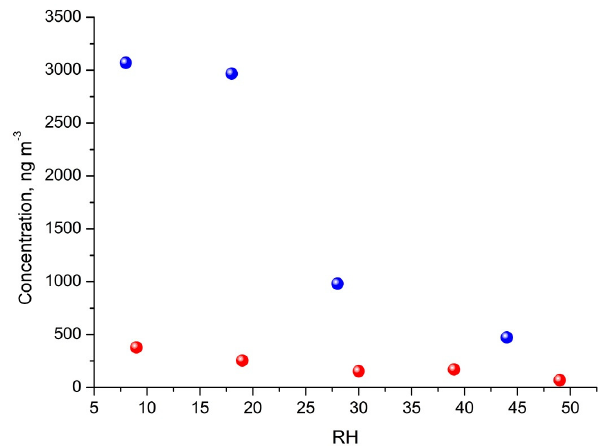
Figure 4. Concentrations of particle-phase products from the acidic-seed experiments estimated with GC-MS.